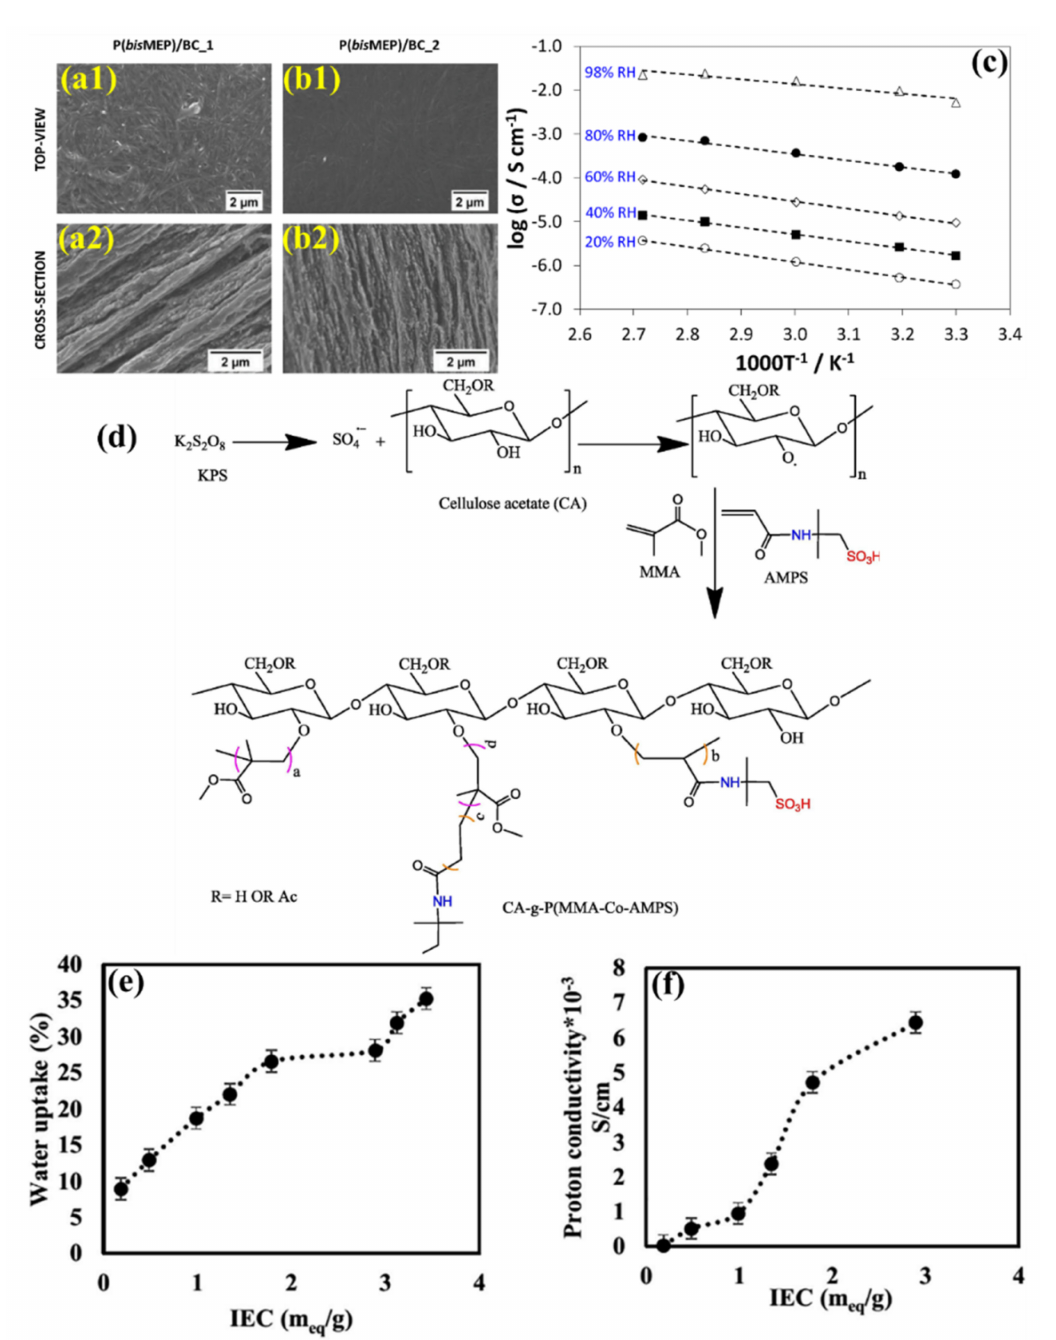
Figure 8. SEM micrograph ( a1 , b1 ) surface and ( a2 , b2 ) cross-sectional view of P( bis MEP)–BC nanocom- posites membranes. ( c ) Proton conductivity (includes Arrhenius plot) of P( bis MEP)–BC membrane at different RH [122]. ( d ) Diagram showing the technique for copolymerizing AMPSA and MMA onto CA. ( e ) Water uptake and ( f ) proton conductivity of CA–g–p(AMPAS–co–MMA) membranes with respect to IEC. Reprinted with permission from Ref. [123]. Copyright © 2021 The Authors. Published by Elsevier B.V. on behalf of King Saud University. (License Number: